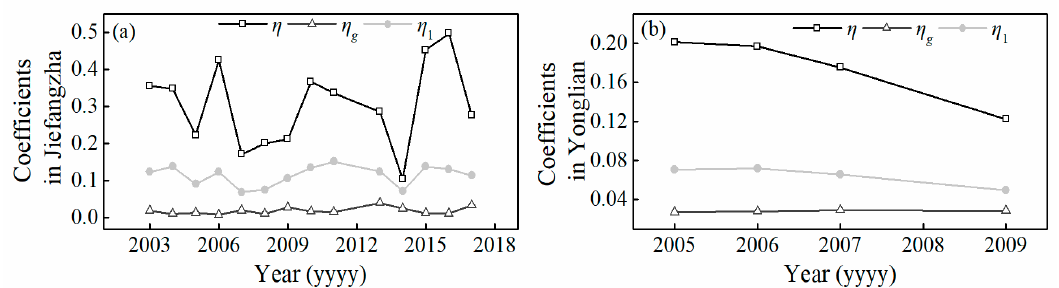
Figure 9. The results of the coefficient of soil ‐ ground water storage utilization ( η ), the coefficient of soil ‐ ground water storage utilization below 1 m soil depth ( η 1 ) and the coefficient of ground water utilization ( η g ) of ( a ) Jiefangzha from 2003 to 2017 (except 2012) and ( b ) Yonglian in 2005, 2006, 2007 and 2009.